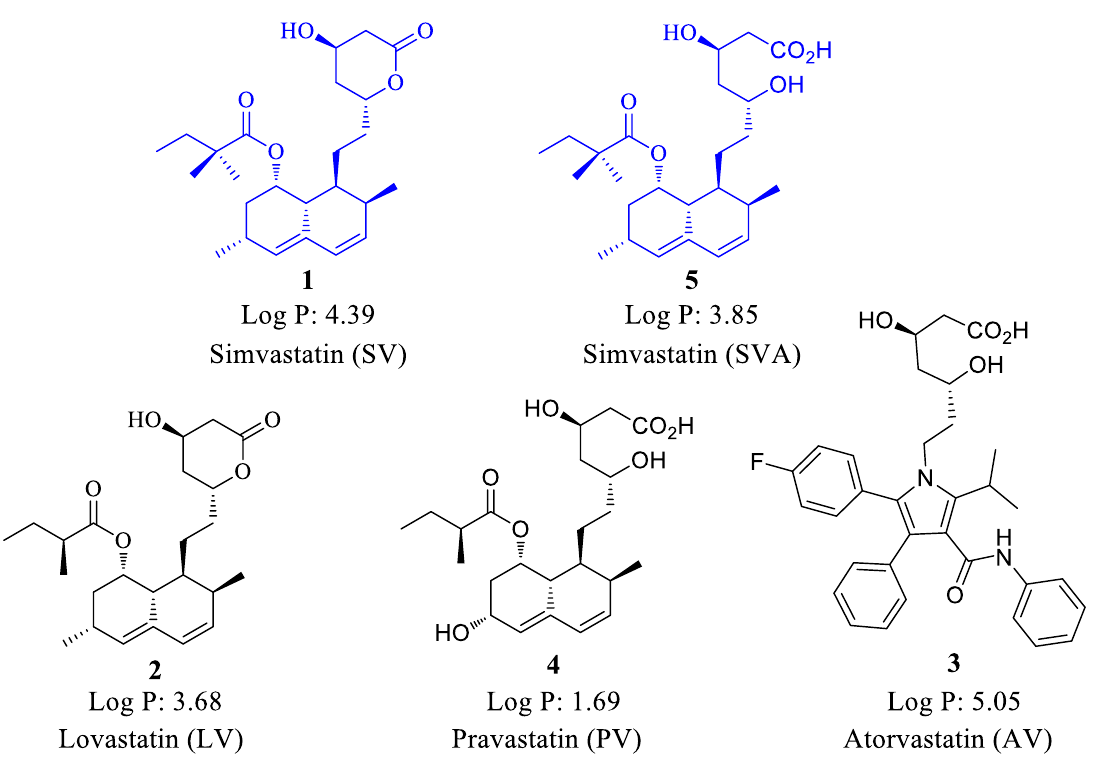
Figure 1. Chemical structures of statins and corresponding log p values. SV ( 1 ), biosynthesized from the fungus Aspergillus terreus [15,16], is a semisynthetic derivative of LV ( 2 ). It has high hepatic extraction and high efficacy in controlling choles- terol synthesis [17], which might be due to the high log p value (log p = 4.39) of SV. SV and another cholesterol-lowering drug, AV, have been used for the clinical treatment of hypercholesterolemia worldwide [16,18]. SV has dihydroxyheptanoic acid and a ring sys- tem with lipophilic substituents. In addition, a modified hydroxyglutaric acid structurally resembles the 3-hydroxyglutaryl unit of both the substrate (HMG CoA) and the interme- diate mevaldyl–CoA transition state [19], making SV a potent competitive inhibitor of HMG-CoA reductase [20]. Regardless of the effectiveness of SV in lowering cholesterol, SV has some rare and serious side effects including liver problems, muscle breakdowns, and in- creased blood sugar levels [21–26], in addition to common side effects including headaches, constipation, and nausea. It has also been reported that people with kidney problems should not absorb higher doses of SV [27]. It is also recommended not to take SV during pregnancy [27,28] and while breast feeding, due to the harmful effects in unborn/new-born babies. In order to maximize its excellent cholesterol-lowering effect and minimize its seri- ous side effects, an in-depth study of its metabolism becomes indispensable to understand the mechanisms underlying its pharmacological effects and its potential side